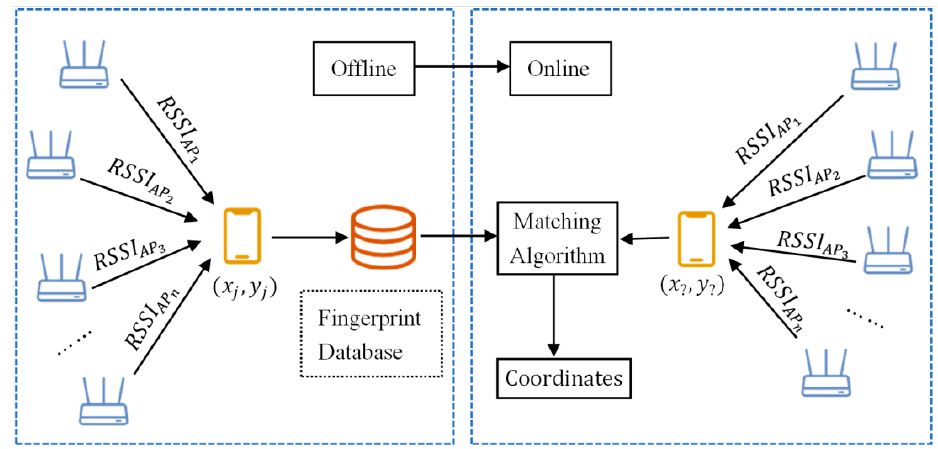
Figure 1. General process of Wi-Fi fingerprint positioning.